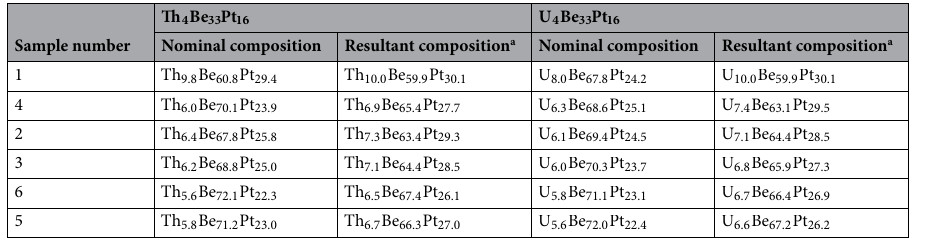
Table 1. Sample summary for U 4 Be 33 Pt 16 and Th 4 Be 33 Pt 16 samples. a Estimated assuming that the mass, lost during arc-melting, is solely that of